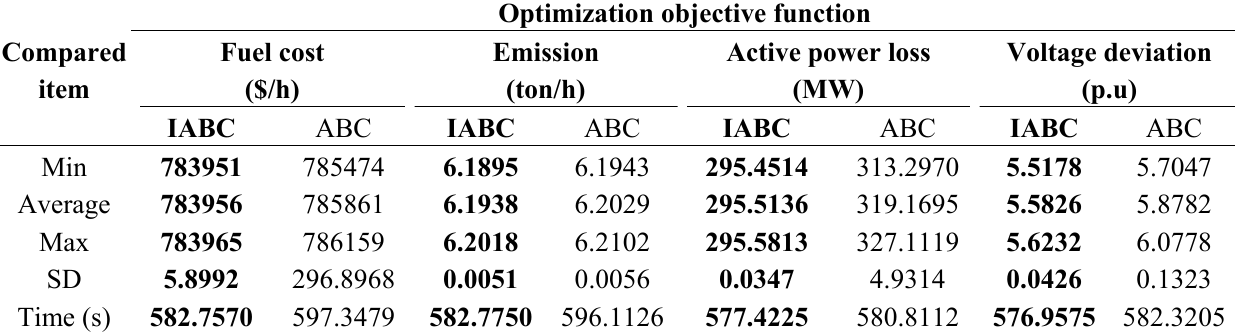
Table 10. Results obtained by the IABC and ABC algorithms for different single objective OPF for the IEEE 300-bus system.